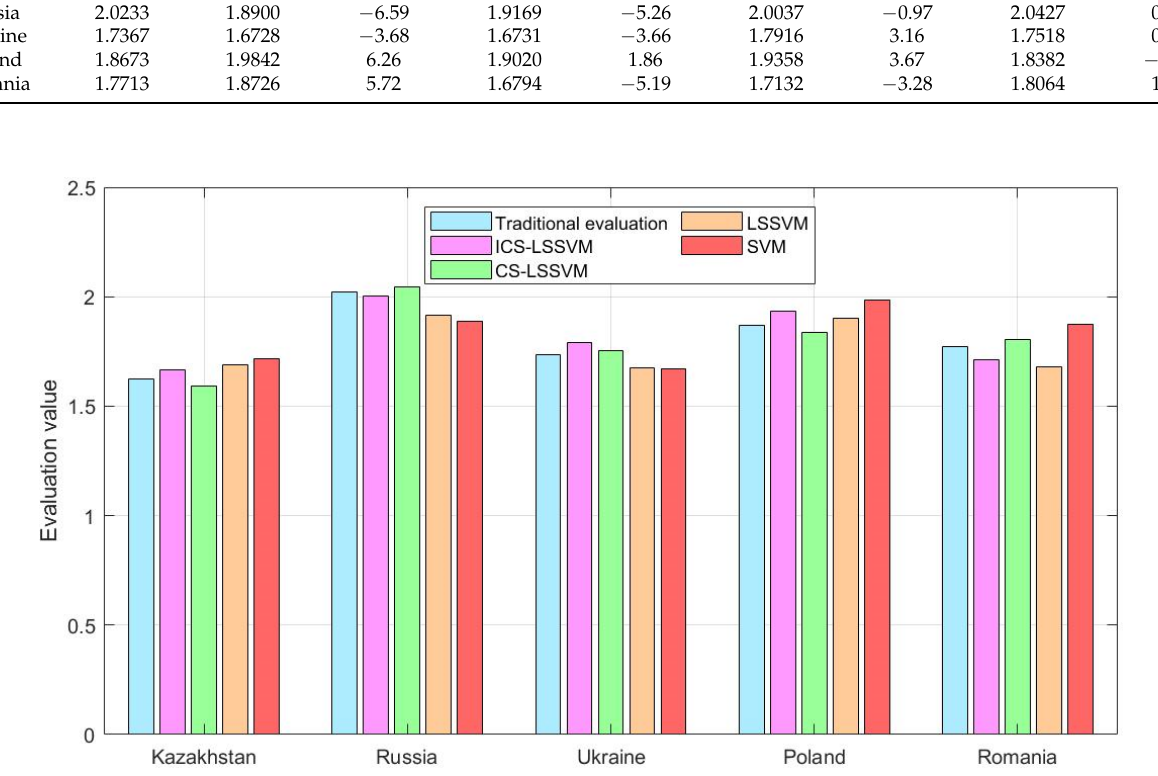
Table 9. Estimation results of the test samples